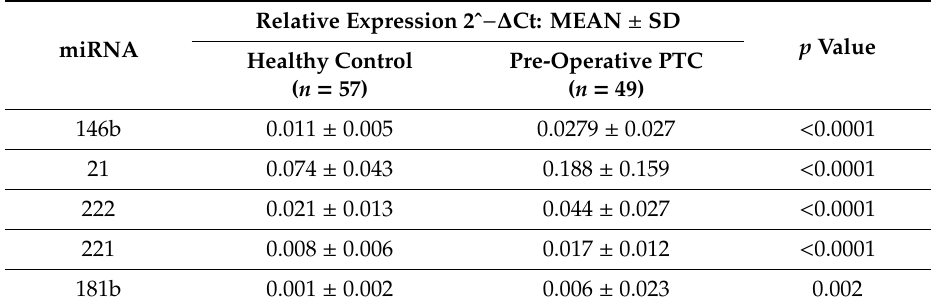
Table A1. miRNA expression comparison between papillary thyroid cancer (PTC) patients before surgery and healthy control plasma samples.